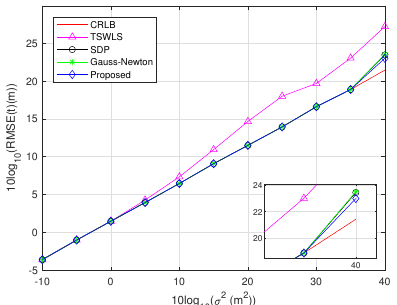
Figure 4. RMSE comparison for estimating target position.